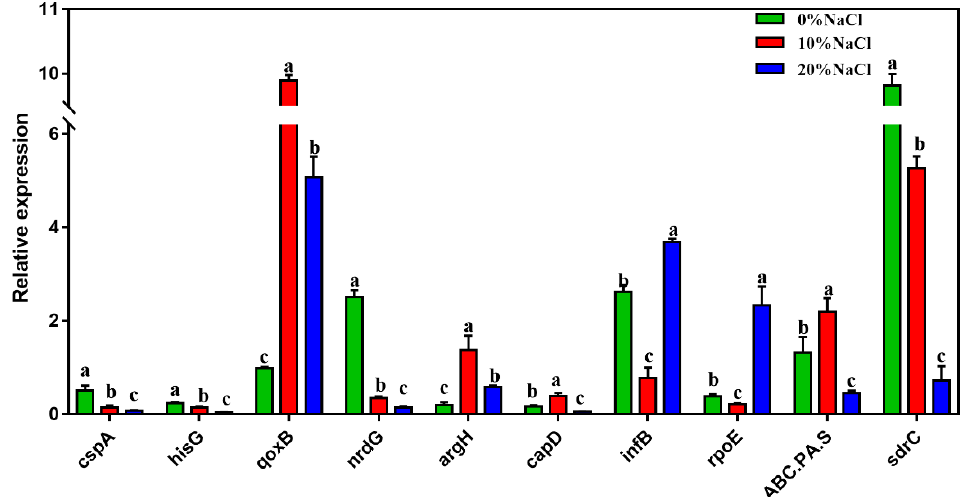
Figure 6. The relative expression of the validation genes. The Y -axis represents the expression of selected genes. Different letters correspond to statistically significant differences ( p < 0.05) between groups.